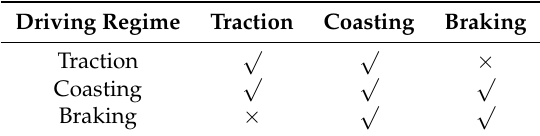
Table 3. Rules for the change of the driving regimes.